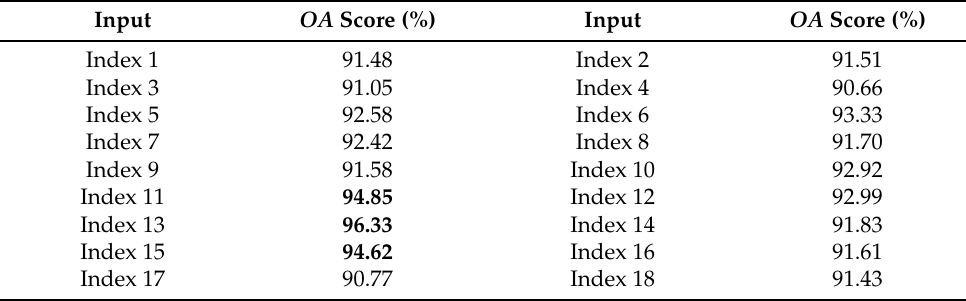
Table 13. Performance with single input of 18 indices.